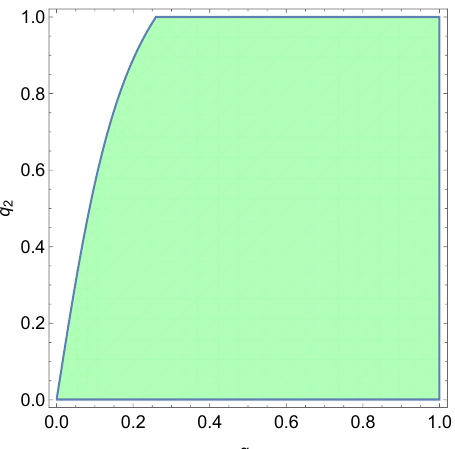
Figure 7 showes region of fractional orders ( q 1 , q 2 ) for which system (18) is globally asymptot- ically stable.